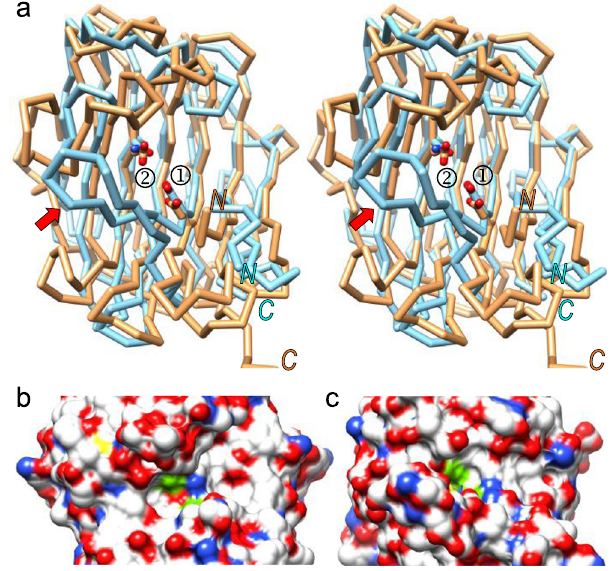
Fig.7|Structuralsimilarityofneprosinandeqolysins.a SuperpositionoftheC α - traces of neprosin (salmon) and SCP-B (pale blue) in stereo, with the respective catalytic residues shown as sticks and labelled ( ➀ , E 297 /E 190 of neprosin/SCP-B; ➁ , E 188 /Q 107 of neprosin/SCP-B). Note the unique fl apof SCP-B covering the active-site cleft (red arrow). The N-terminus and C-terminus are indicated. b Close-up of the active-sitecleftofneprosinshown forits Connollysurface in the orientation of ( a ). The two catalytic residues are shown (green patches). c Same as (b) for